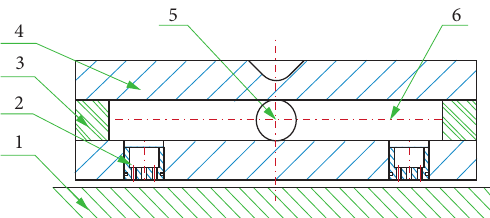
Figure 2: Schematic diagram of the working principle of the aerostatic bearing with a multihole integrated